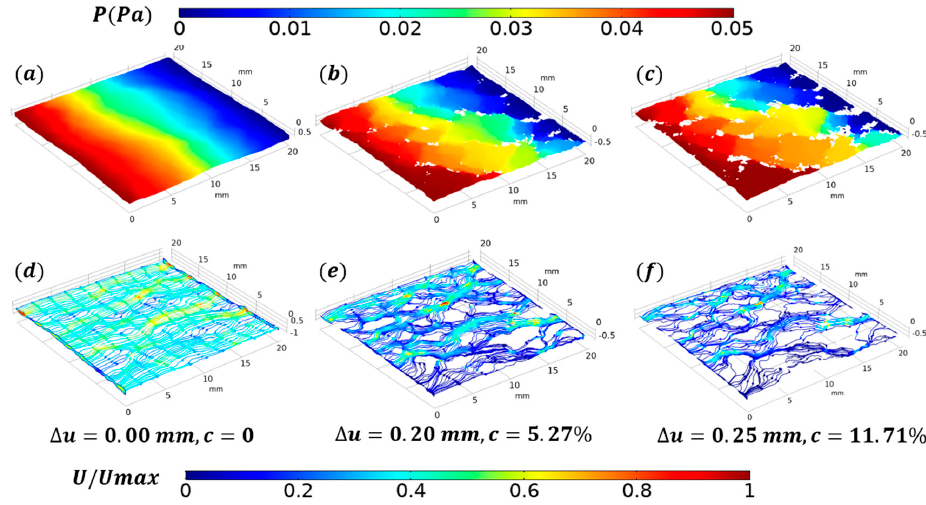
Figure 6. Variations of pressure fields and flow streamlines for fractures of different Δ u with H = 0.65: ( a – c ) are pressure fields (unit: Pa); and ( d – f ) are flow streamlines.